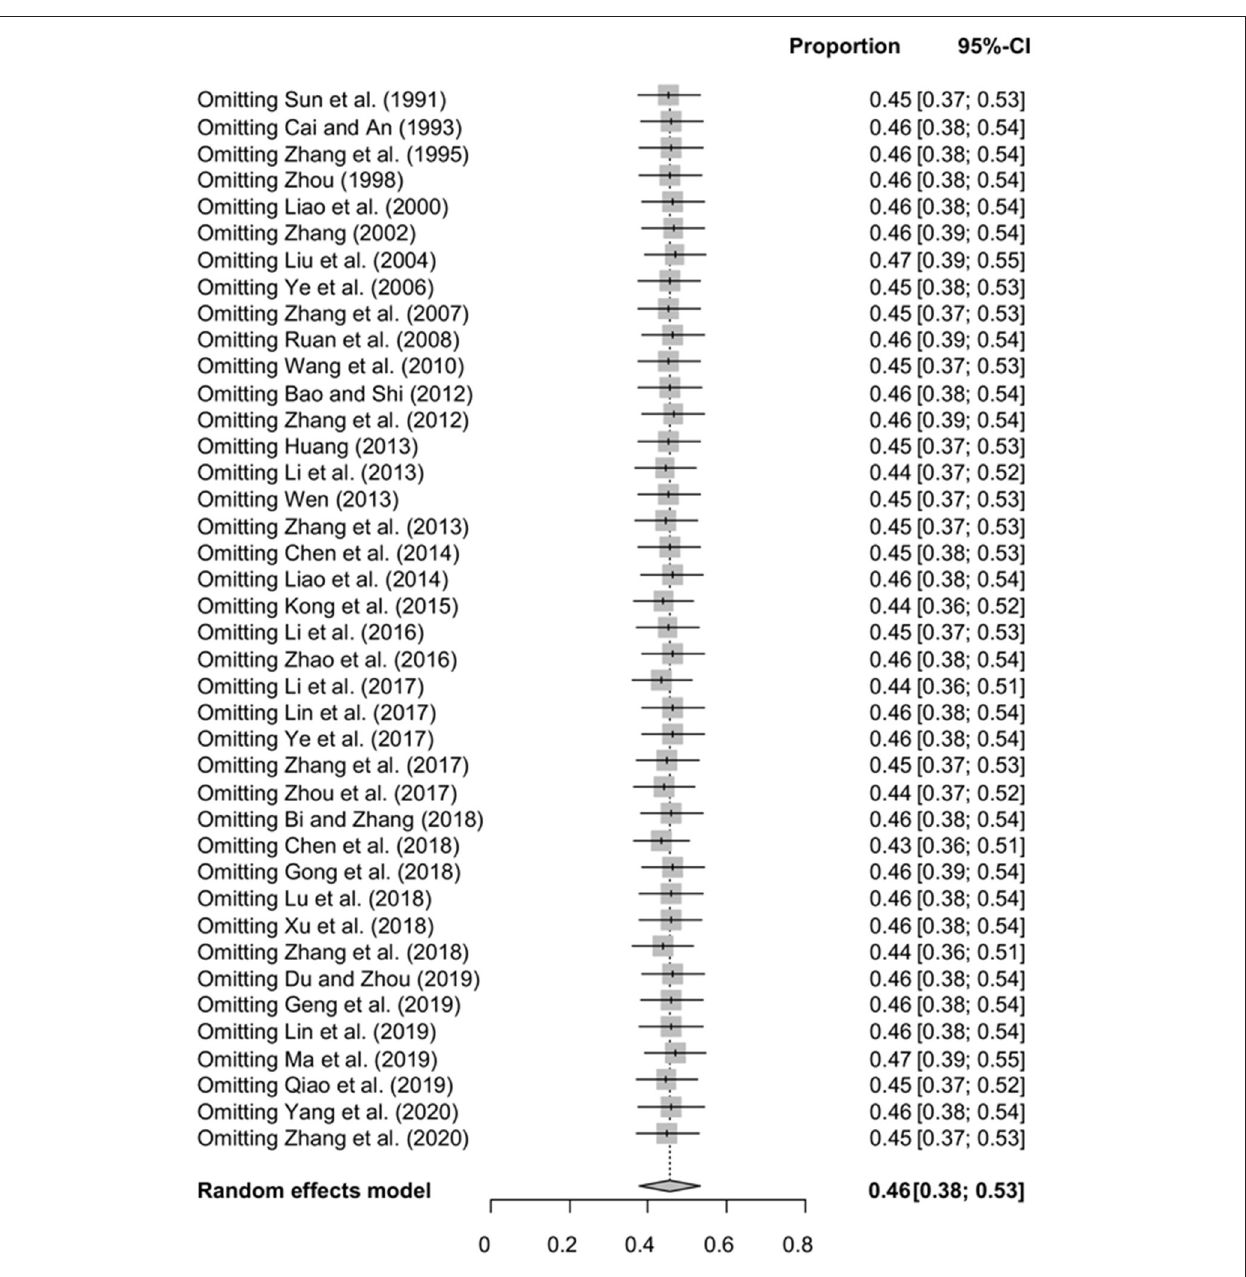
FIGURE 7 | Sensitivity